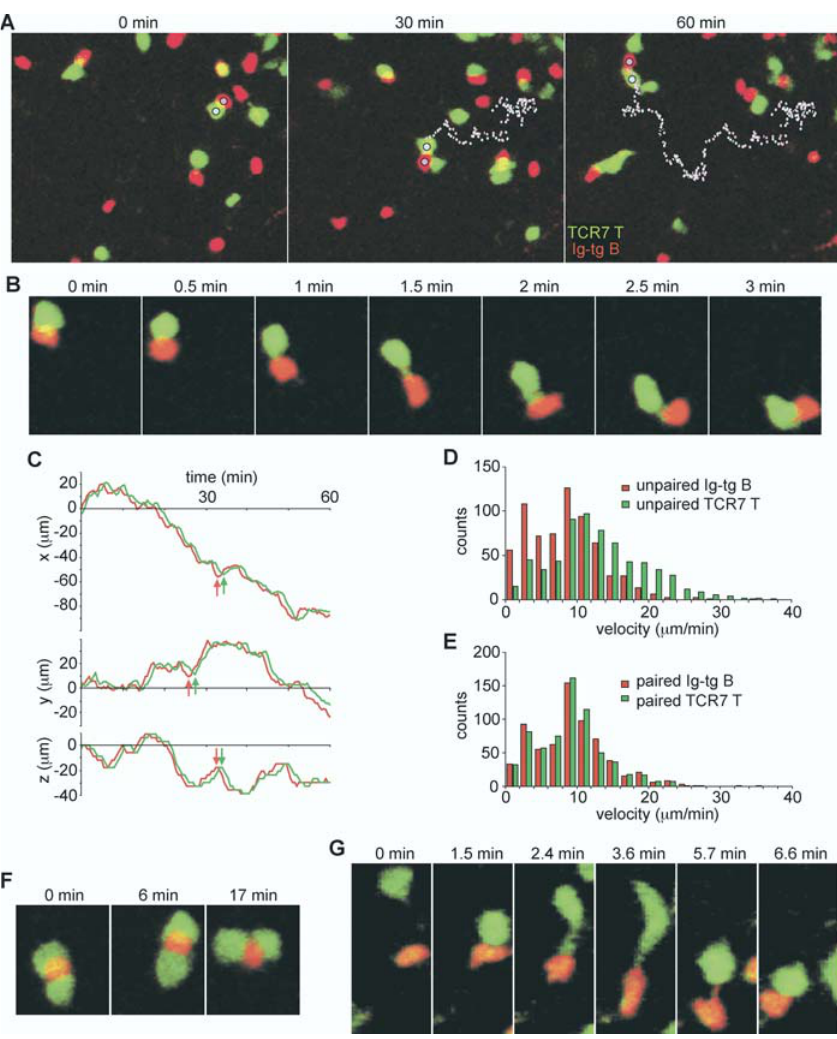
Figure 6. Dynamics of Antigen-Engaged B Cell–Helper T Cell Interactions (A) Time-lapse images of Ig-tg B cells interacting with TCR7 CD4 þ T cells ; 30 h after immunization with HEL in adjuvant, showing T cells moving along behind B cells. The pathways of a B cell (pink dotted line) and a T cell (blue dotted line) remaining bound to each other for more than 1 h are shown (see also Video S5). (B) Time-lapse images showing the dynamics of a B-T conjugate. (C) The t-x, t-y, t-z plots of the interacting B (red line) and T (green line) cells traced in (A). Note the B cell makes turns before the T cell (arrows). (D and E) Velocity measurements of unpaired (D) and paired (E) B and T cells, showing that paired T cells slow to the velocity of the B cell. Velocity data are from 16 cells of each type. (F) Time-lapse images of a B cell interacting with two T cells. (G) Time-lapse images showing an encounter of a B cell and a T cell to form a conjugate. DOI: